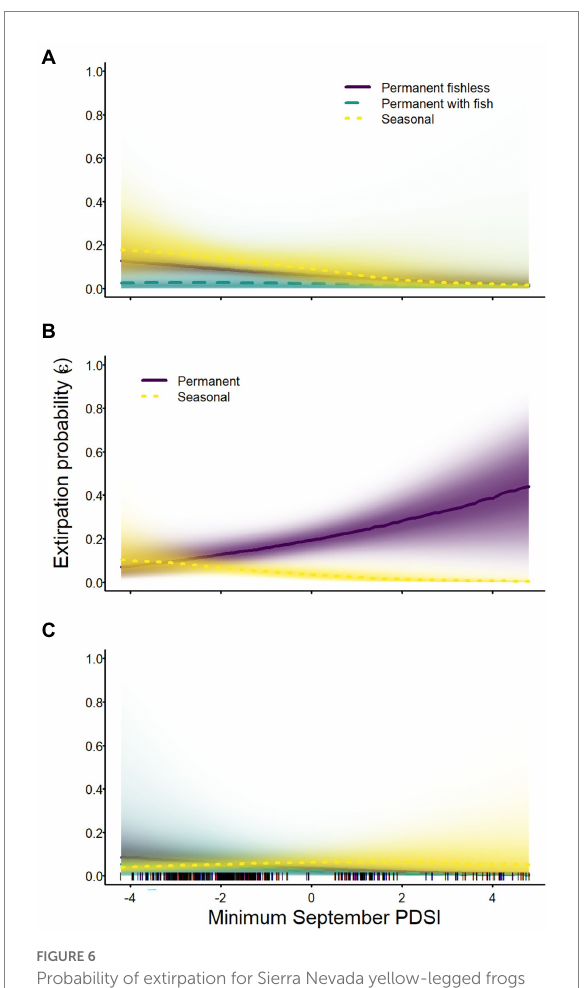
FIGURE 8 Annual probabilities of reproduction (conditional on adult occurrence) for Sierra Nevada yellow-legged frogs [ Rana sierrae ; (A) ], Yosemite toads [ Anaxyrus canorus ; (B) ], and sierran treefrogs [ Pseudacris sierra ; (C) ] by site type (indigo circles and line = permanent [and fishless for panels (A,C) ]; aqua squares and line = permanent with fish; gold diamonds and line = seasonal) based on modeled relationships with climate variables and random annual variation in Yosemite National Park, California, United States, 2007–2021. Points represent posterior medians; error bars represent 95% equal-tailed